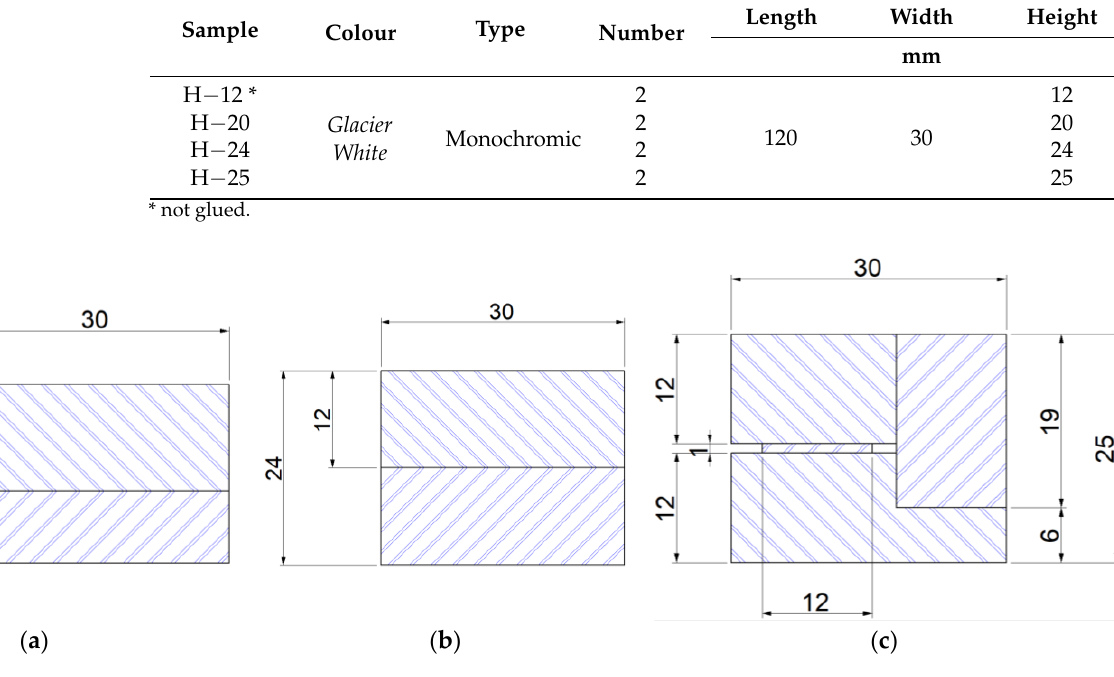
Figure 1. Cases of gluing of artificial cast stone: ( a ) H − 20; ( b ) H − 24; ( c ) H − 25.